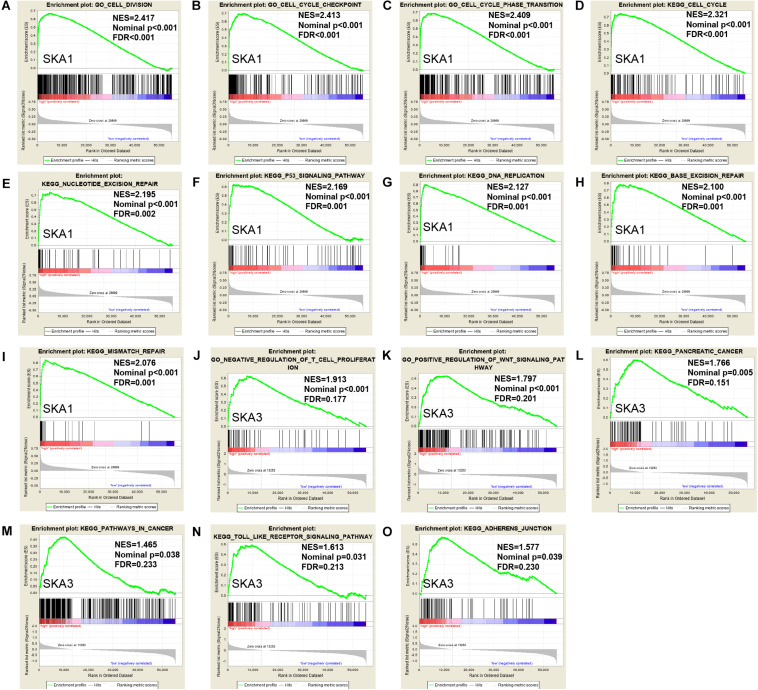
Gene set enrichment analysis of SKA1 and SKA3 in TCGA dataset. (A–C, J, K) GSEA results of C5 gene sets for high SKA1 and SKA3 expression groups; (D–I, L–O) GSEA results of C2 gene sets for high SKA1 and SKA3 expression groups; NES, normalized enrichment score; FDR, false discovery rate.